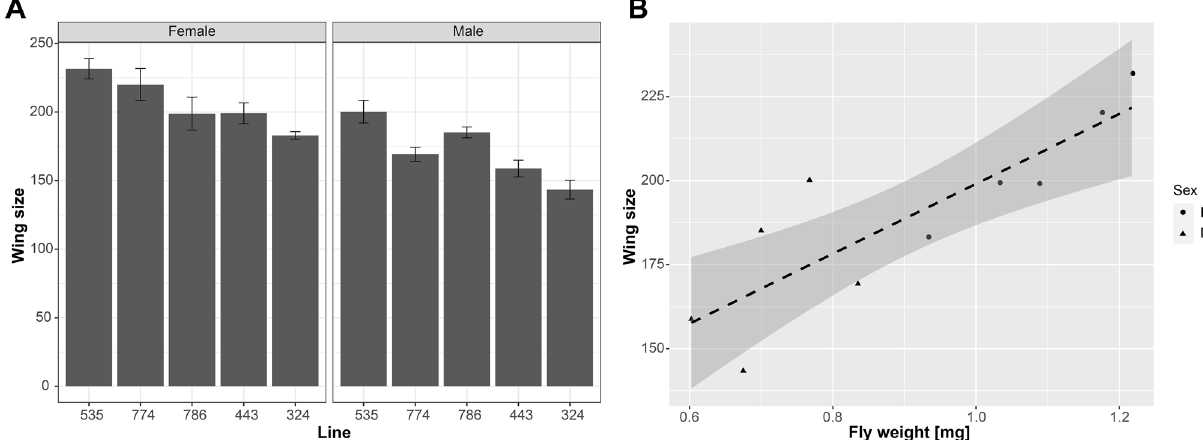
Figure 6. Wing size is strongly correlated with animal weight. ( A ) Wing size (Y-axis, measured in pixels) varies significantly in the DGRP strains examined (Lines, X-axis), with females (left) having consistently larger wings than males (right). Error bars: standard errors, n = 10. ( B ) Fly weight (X-axis, in mg) is strongly correlated with wing area (Y-axis, measured in pixels). Trend line shown in black (dashed) with standard error. Data from females are circles, data from males are triangles.